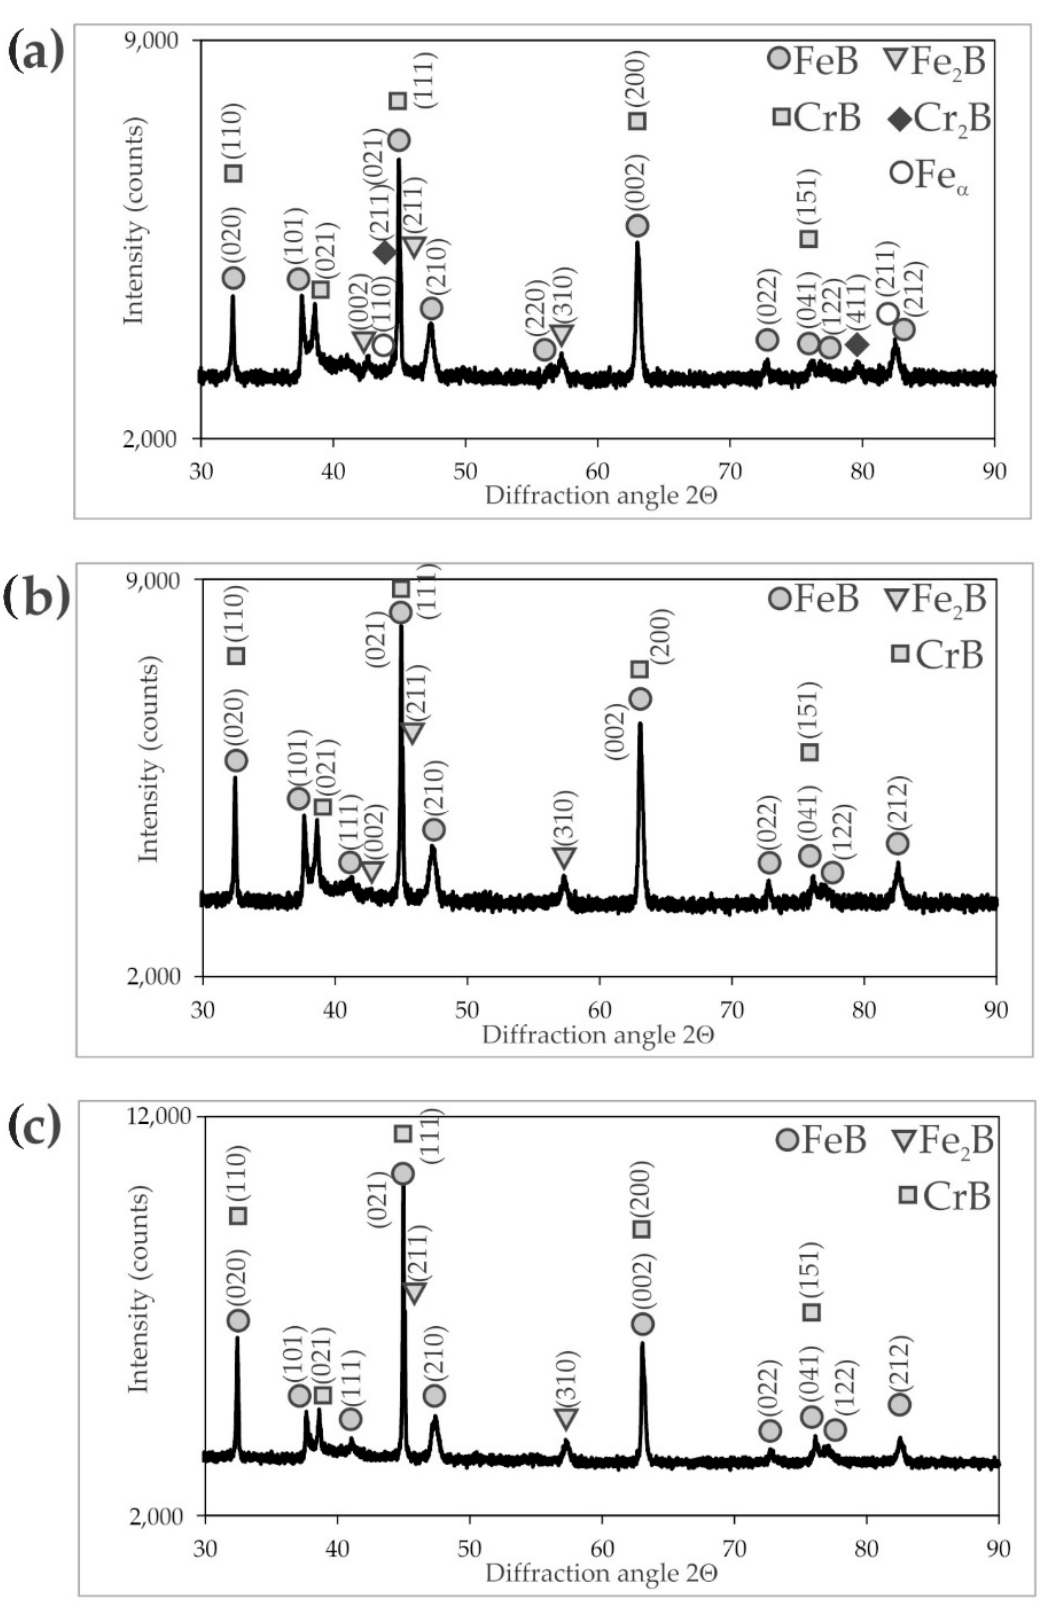
Figure 3. XRD patterns of X165CrV12 steel after powder-pack boriding at 1123 K: ( a ) for 3 h, ( b ) for 6 h, ( c ) for 9 h.